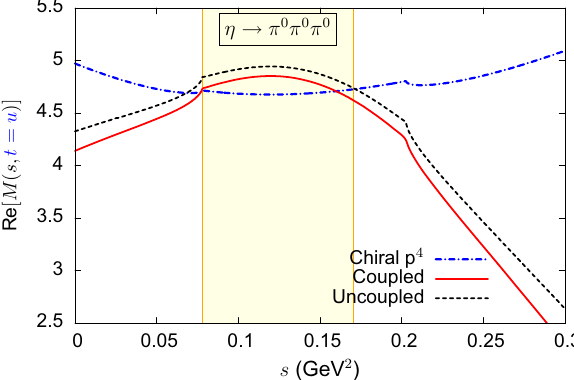
Fig. 8 Real part of the η → 3 π 0 decay amplitude along the t = u line as a function of s . The lines are as in Fig.